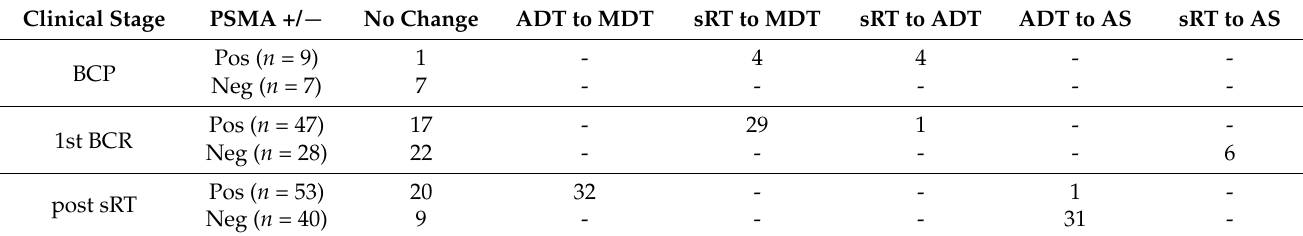
Table 4. Changes in treatment management after PSMA-PET/CT at different clinical